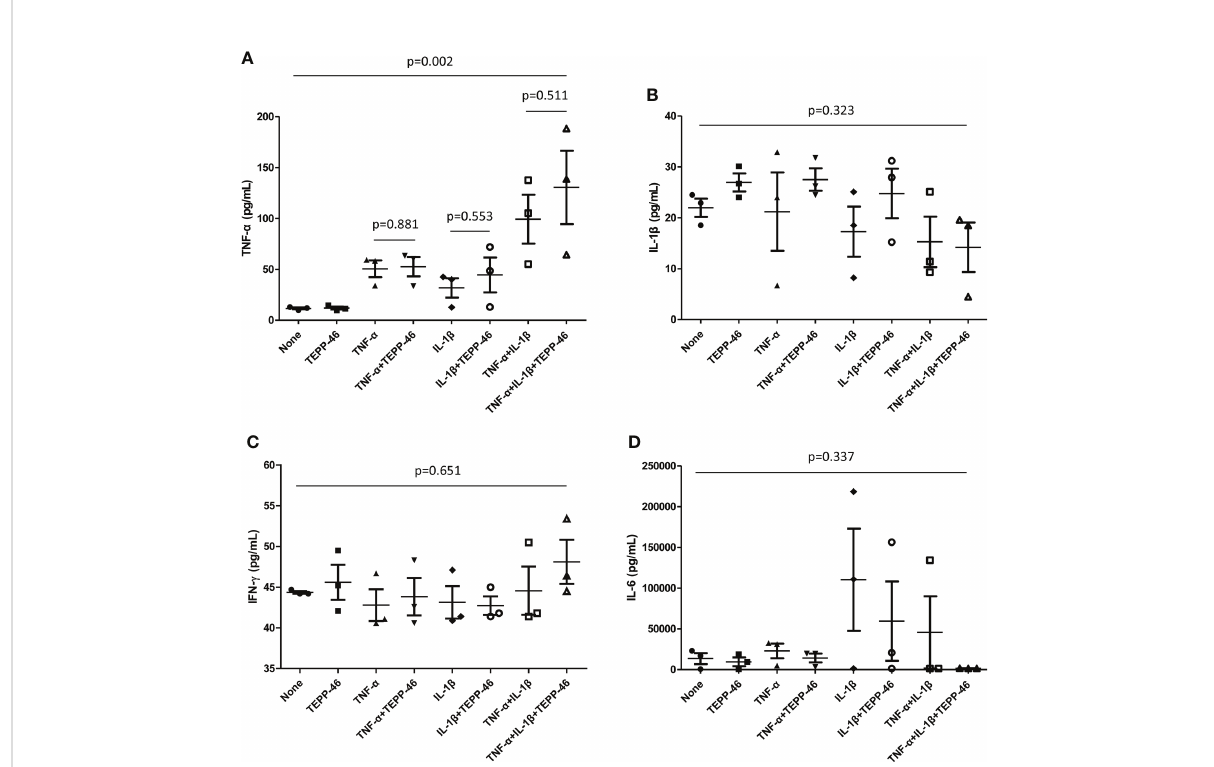
FIGURE 9 Cytokine assays of supernatant from FLS. FLS (1.5×10 5 cells) obtained from patients with RA was stimulated by TNF- a or IL- b (100unit) in the presence and absence of TEPP-46 (10 m M), a PKM2 activator. After 72 hours, the cytokines of (A) TNF- a , (B) IL- b , (C) IFN- g , and (D) IL-6 in the supernatant was measured by duplicate experiments of enzyme-linked immunosorbent assay. Differences of two groups were evaluated by student ’ s t-test, whereas Analysis of Variance was used to compared the differences of more than three groups. The error bars indicate mean and SEM. FLS: fi broblast-like synoviocytes; RA, rheumatoid arthritis; TNF, tumour necrosis factor; IL, interleukin; PKM2, pyruvate kinase isoenzyme M2; IFN,